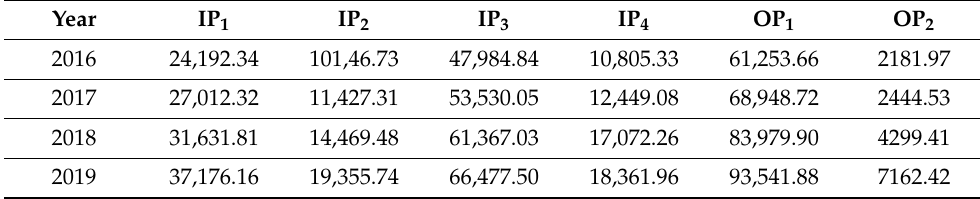
Table 8. Data of AG 4 2016–2019 (Unit: 1000